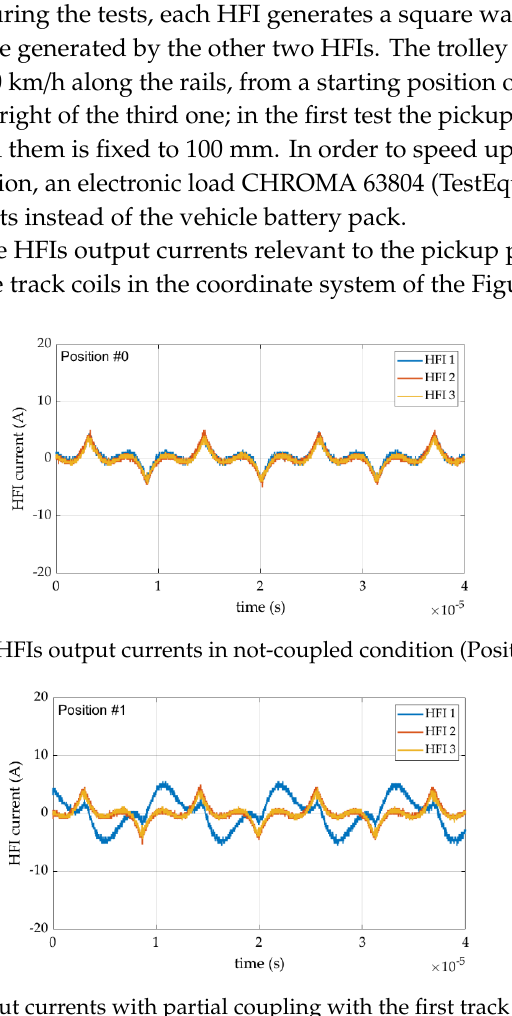
Figure 17. HFIs output currents with partial coupling with the first track coil (Position #1).